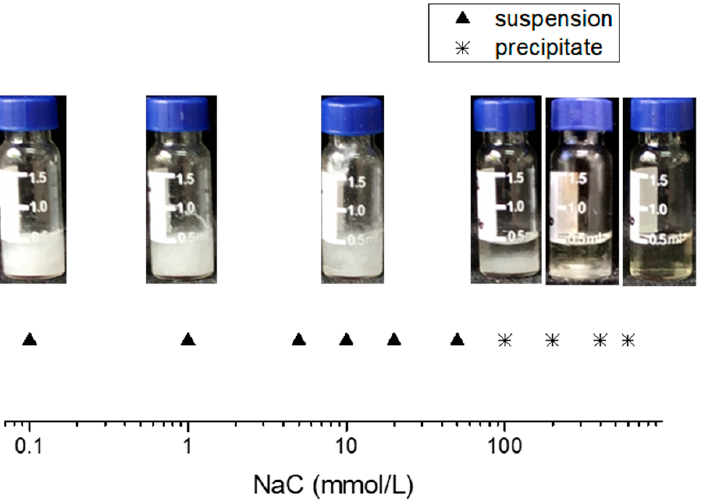
Figure 1. The phase diagram of FF/NaC mixtures with a concentration of FF of 10 mmol/L. We performed optical microscopy observations in an aqueous solution to show the morphologies of the assembled aggregates above the fixed FF concentration of 10 mmol/L (Figure S3). The microstructures of naturally dried samples were also investigated by SEM and TEM observations in Figure 2 and Figure S4, which are in agreement with the optical microscopy results. Small amounts of NaC barely affect the aggregates, which remain the same ultralong microrods that grow up to several millimeters in length linearly and unidirectionally in pure water (Figure 2a,b). However, as the concentration increased to approximately 5 mmol/L, we observed broom-like structures (Figure 2c) with lengths from 400 to 1000 µ m and a stability of up to one month. The video in the Supporting Information shows the growth process of the broom-like structures. It proves that the assembly grows from the nucleus and then starts to become branched. After that, the branches gradually grow longer, and they produce the final structure in less than two min- utes. Furthermore, the ends of the broom-like crystals in Figure 2d clearly show the same hexagonal shapes as the FF microrods in water. Broom-like rods appear when adding FF into different concentrations of NaC solutions from 5 to 12 mmol/L (Figure S5). After the NaC concentration rises to 20 mmol/L, it still shows ultralong rods (Figure 2e,f). With an increasing NaC concentration, the amount of FF aggregations decreases remarkably, as the images in Figure 1 show. At an NaC solution concentration of 500 mmol/L, the FF failed to assemble into rods, and after one month the fragments left without forming any